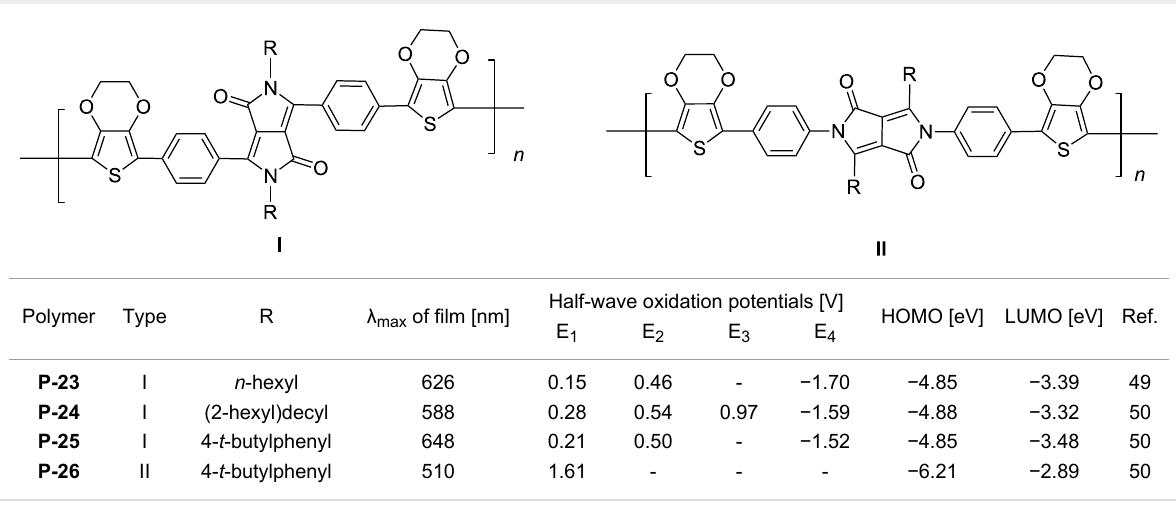
Table 4: List of DPP-polymers prepared upon electrochemical polymerization.